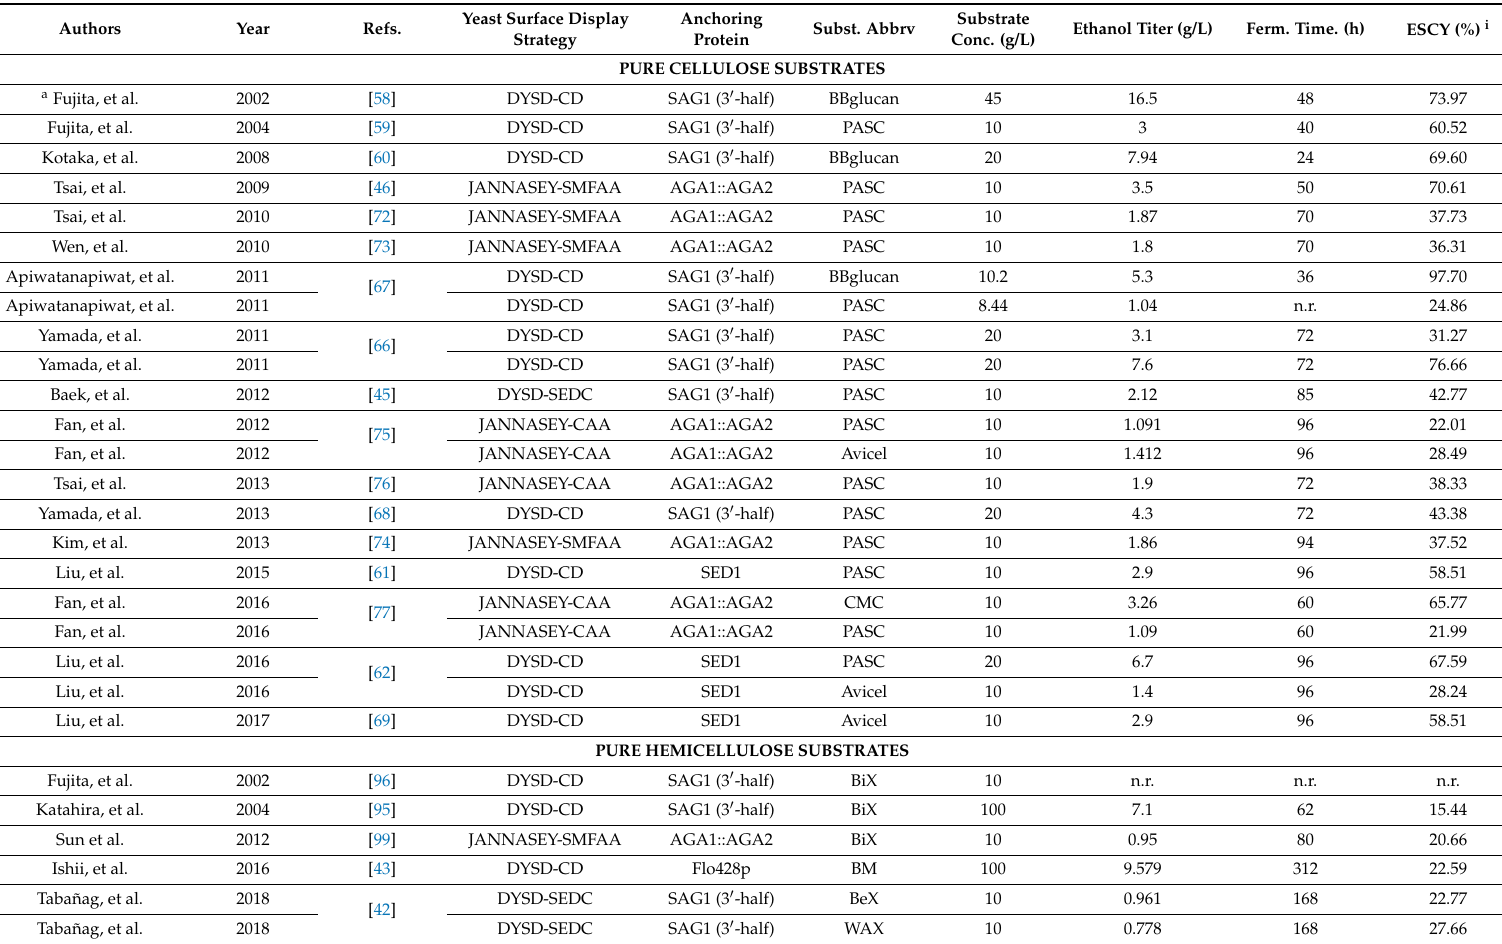
Table A1. List of references collated with respect to the substrate types targeted by the different yeast surface display